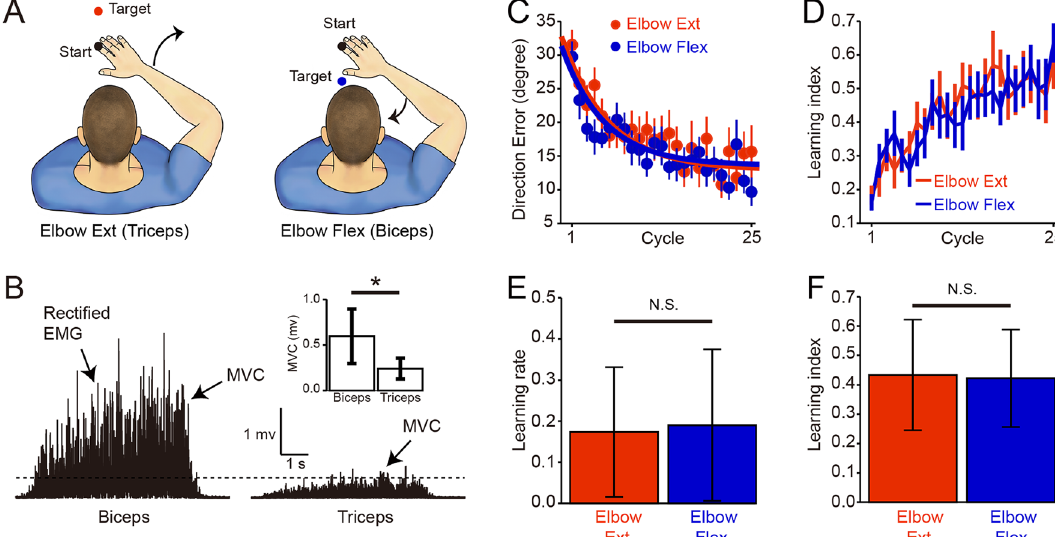
Figure 3. Muscle weakness and motor adaptation learning. ( A ) Subjects reached to the target required elbow extension (Elbow Ext = target positioned in the midline in front of the start circle) or elbow flexion (Elbow Flex = target positioned in the midline behind the start circle). ( B ) Rectified EMG activity in the biceps and triceps brachii in a representative SCI subject when the subject performed maximum voluntary contraction (MVC). Note that SCI subjects showed higher MVC values quantified by EMG signals in biceps compared with triceps brachii. ( C , D ) Group data showing changes in direction errors at peak tangential arm velocity during reaching movements towards a target where the reaching movement required elbow extension (red) or flexion (blue). ( E , F ) Group data showing learning rate ( E ) and mean learning index ( F ) during elbow extension and elbow flexion. Error bars indicate SDs. *p <